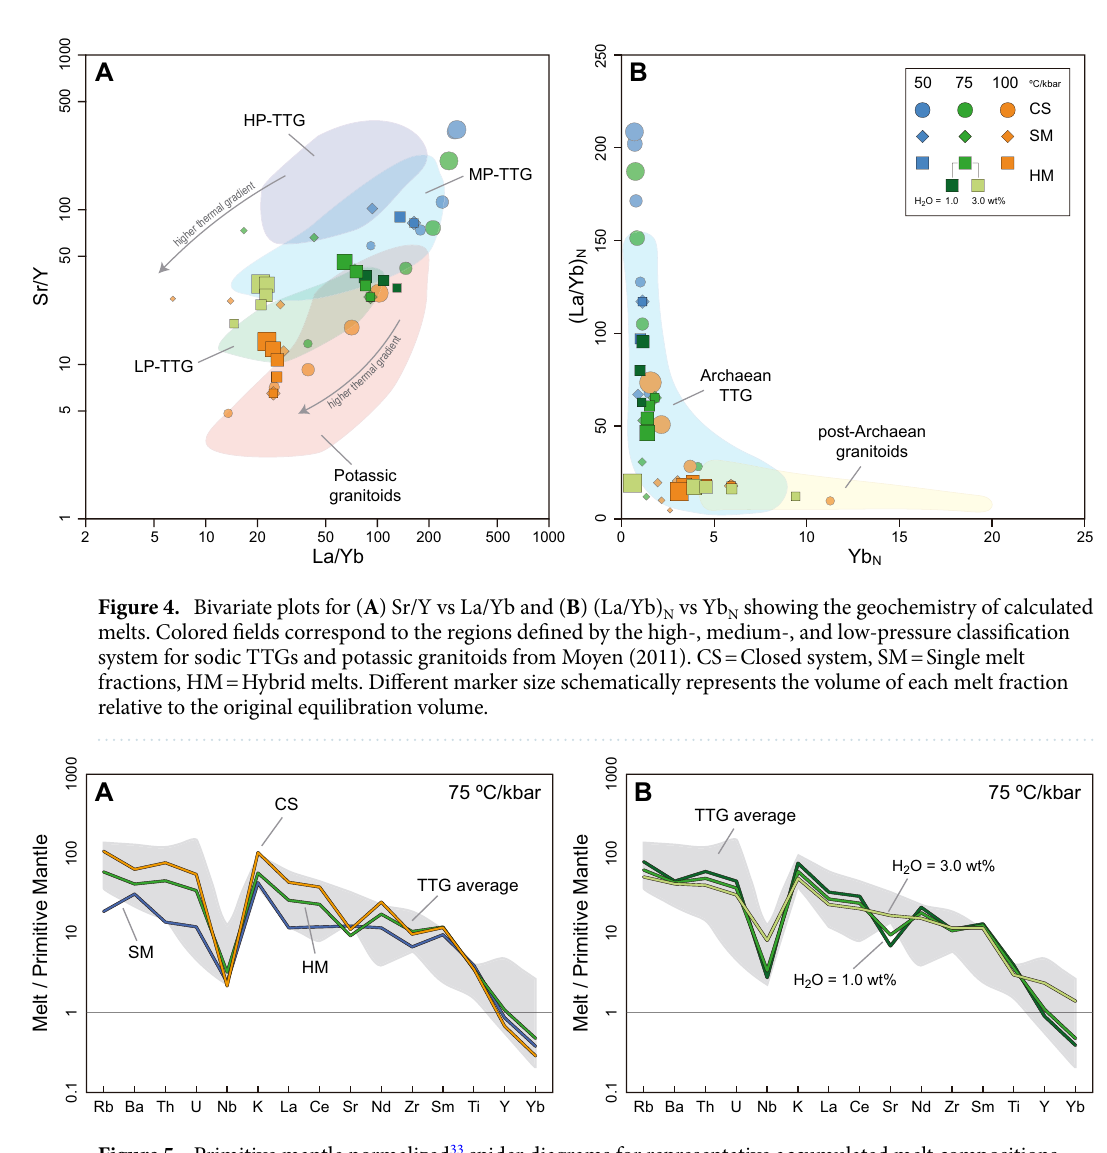
Figure 5. Primitive mantle normalized 33 spider diagrams for representative accumulated melt compositions generated along the 75 °C/kbar geotherm. ( A ) Melts produced during the third MLE with a minimally water saturated protolith. ( B ) Melts produced during the third MLE considering partial melting of the protolith under fluid absent (1.0 wt% H 2 O), minimally water-saturated solidus, and water-excess conditions (3.0 wt% H 2 O). CS = Closed system, SM = Single melt fractions, HM = Hybrid